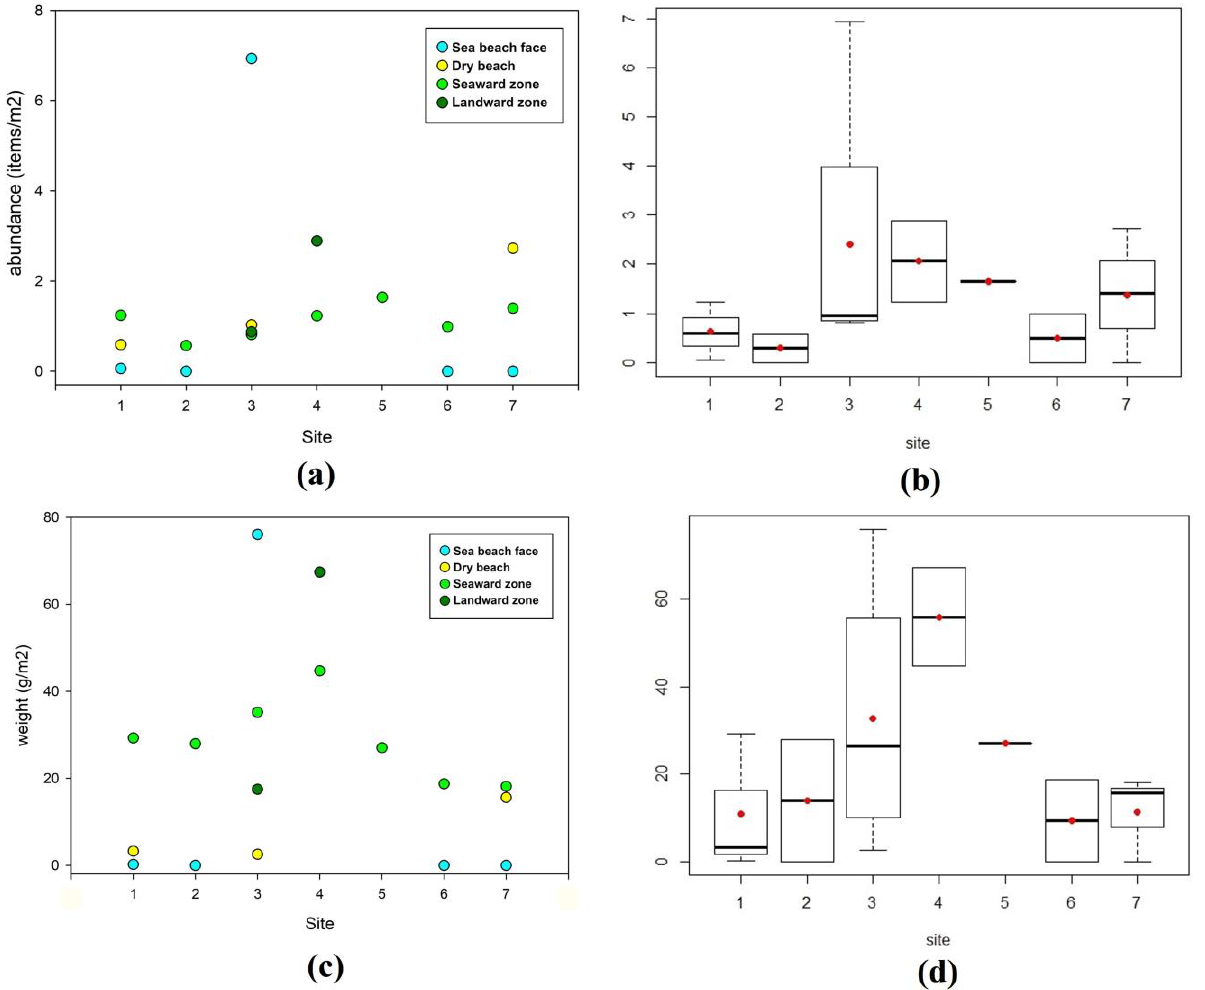
Figure 3. Caribbean Sea coast. ( a ) Litter abundance (items/m 2 ) at all beach/mangrove zones per site. ( b ) Box plots concerning litter abundance values (items/m 2 ) per each site investigated; red dots represent mean values and black lines median values. ( c ) Weight of recollected litter items (g/m 2 ) at all beach/mangrove zones per site. ( d ) Box plots concern weights of litter items (g/m 2 ) per site.